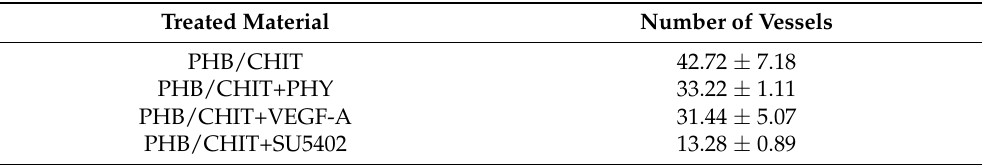
Table 2. Number of the vessels in the surrounding area of the PHB/CHIT scaffolds 72 h after the implantation (ED10). Values are means ± SD of n = 3 independent experiments. Experimental groups included n = 6 samples of the scaffold for each